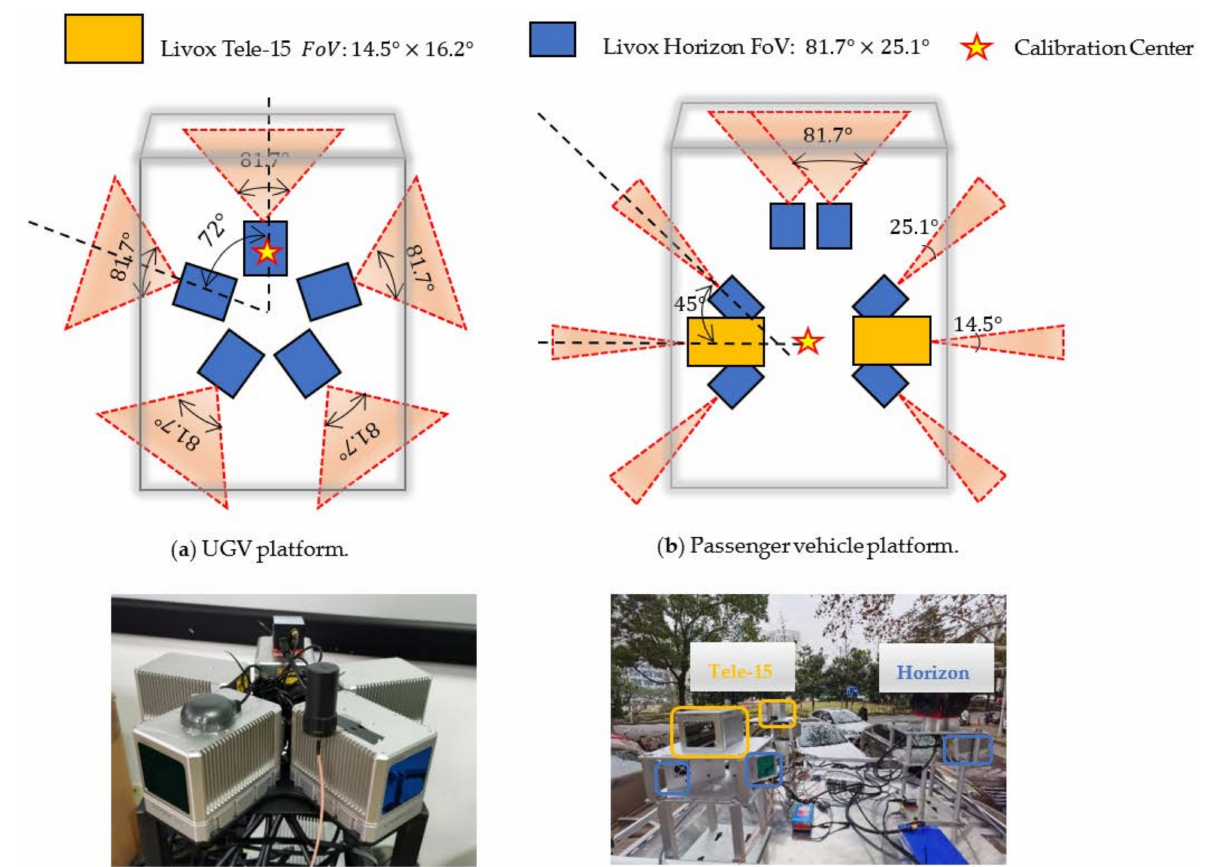
Figure 2. The sensor configuration of our two multiple-lidar systems. The extrinsic is refined to the front-view lidar in ( a ), and the geometric center in ( b ), respectively. Five Livox Horizon lidars were included in the UGV platform, composing a 360 ◦ FoV. While, the passenger vehicle platform had two Livox Tele-15 and six Livox Horizon lidars, with no overlaps between any two lidars.